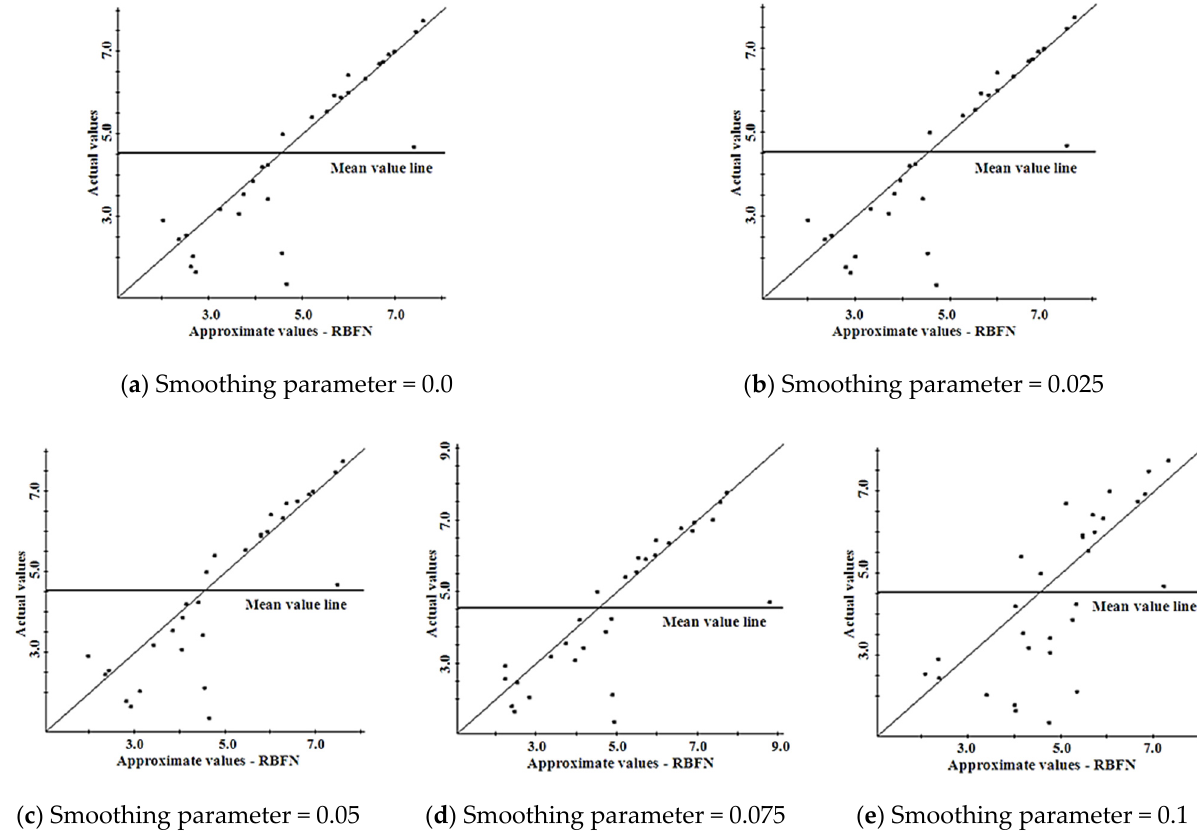
Figure 5. Error scattering analysis according to variation of SSP in Ackley’s path function. Similar to the RMSE results, the error scattering results were varied slightly until the SSP value was increased up to 0.05, whereas the error scattering points deviated from the actual values were increased significantly as the SSP value exceeded 0.05. As shown in of SSP.